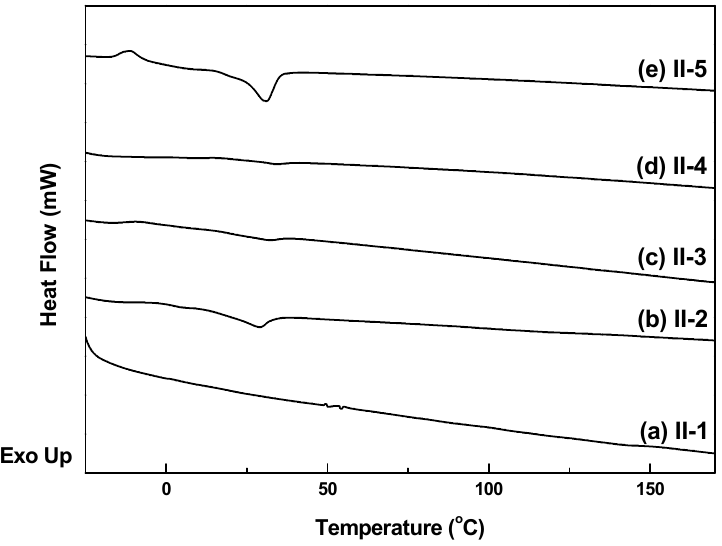
Figure 2. DSC thermograms of polymers II-1 – II-5 (second heating cycle obtained at a heating rate of 10 ◦ C / min). Table 1. Thermal properties of polymers II-1 − II-5 (determined during the second heating cycle).